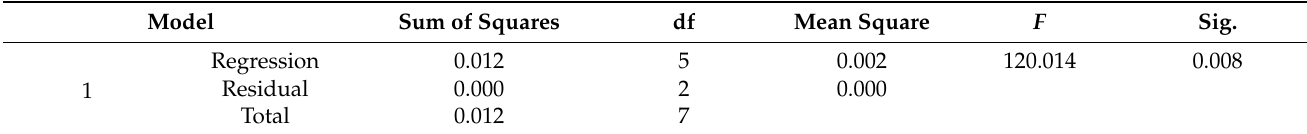
Table 7. Variance analysis of 5 variables.